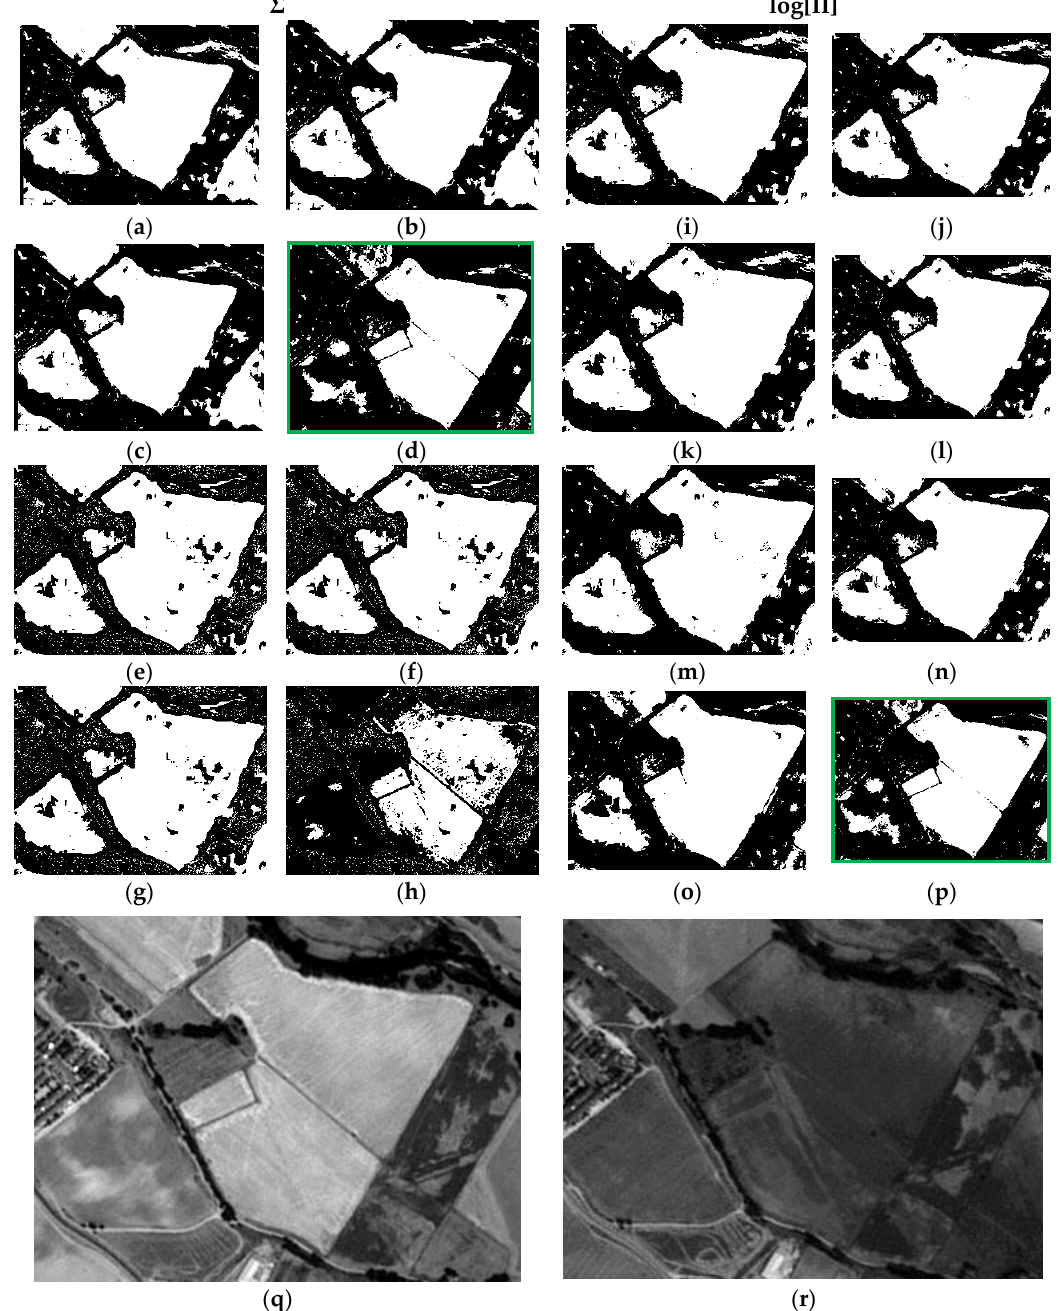
Figure 12. Probabilistic Information Fusion Results in DS1A2: ( a ) c1; ( b ) c2; ( c ) c3; ( d ) c4; ( e ) c5; ( f ) c6; ( g ) c7; ( h ) c8; ( i ) c9; ( j ) c10; ( k ) c11; ( l ) c12; ( m ) c13; ( n ) c14; ( o ) c15; ( p ) c16; ( q ) DS1A2 2005 SPOT-PAN image; ( r ) DS1A2 2008 SPOT-PAN image.